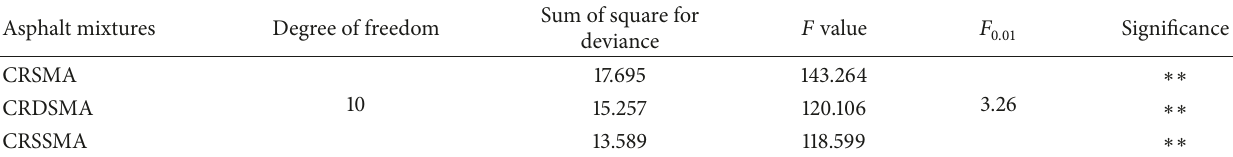
Table 8: Analysis of variance (ANOVA) of F-T cycles on air void.